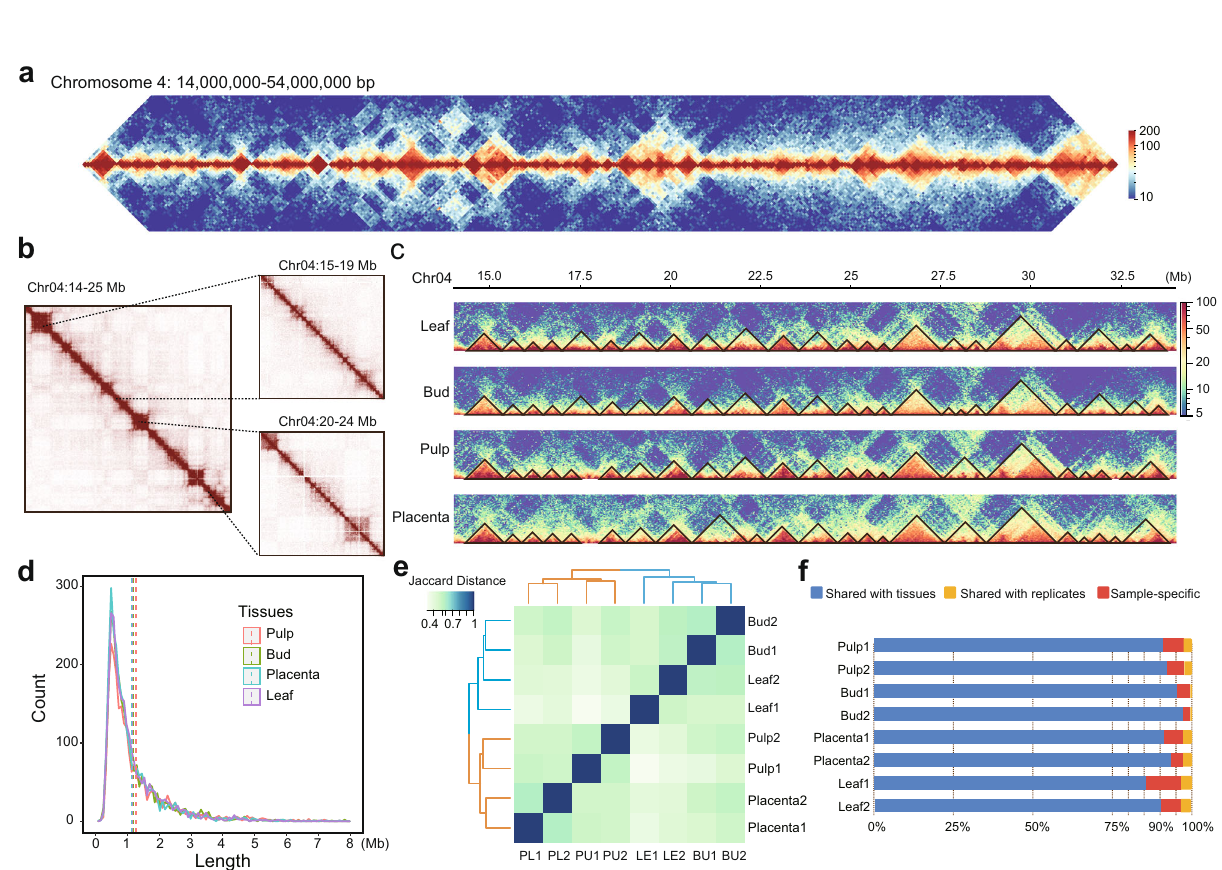
Fig. 3 The pepper genome is organized into TAD-like folding domains. a Example of TAD-like domains on a 40-Mb region of chromosome 4. This region is nearly completely segmented into TAD-like domains along their entire length. Leaf Hi-C interaction map at 100 kb resolution is shown. TADs are contiguous regions of enriched contact frequency that appear as squares in a Hi-C map. b Small contiguous domains show from Hi-C maps at higher resolutions, e.g., 40 kb (left), 10 kb (top right), and 5 kb (bottom right). c TAD-like domains are generally consistent across tissues. d The size distribution of TAD-like domains. Vertical dashed lines indicate mean values. e Hierarchical clustering analysis of TAD-like domains based on the Jaccard distance of their shared genome coverage across tissues and biological replicates. As expected, tissues are generally clustered together. f Conservation of domains across tissues. Domains used for analyses in ( c – f ) were annotated by TopDom at 40 kb resolution. Source Data underlying Fig. 3d – f are provided as a Source Data fi